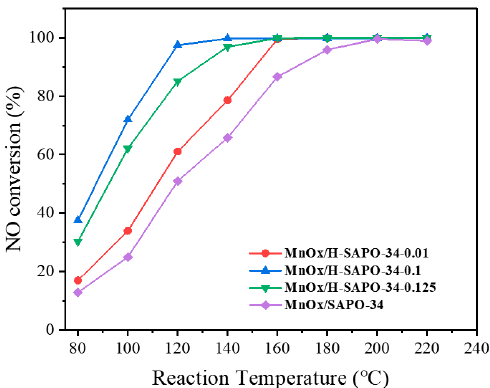
Figure 12. SCR activity of MnO x /H-SAPO-34-0.01, MnO x /H-SAPO-34-0.1, MnO x /H-SAPO-34-0.125 and MnO x /SAPO-34